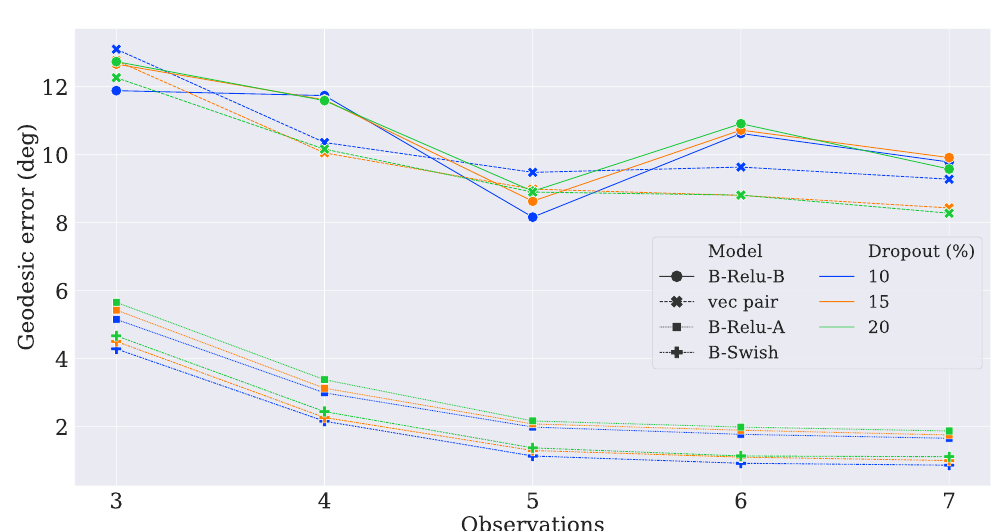
Figure 2. Wahba’s loss.